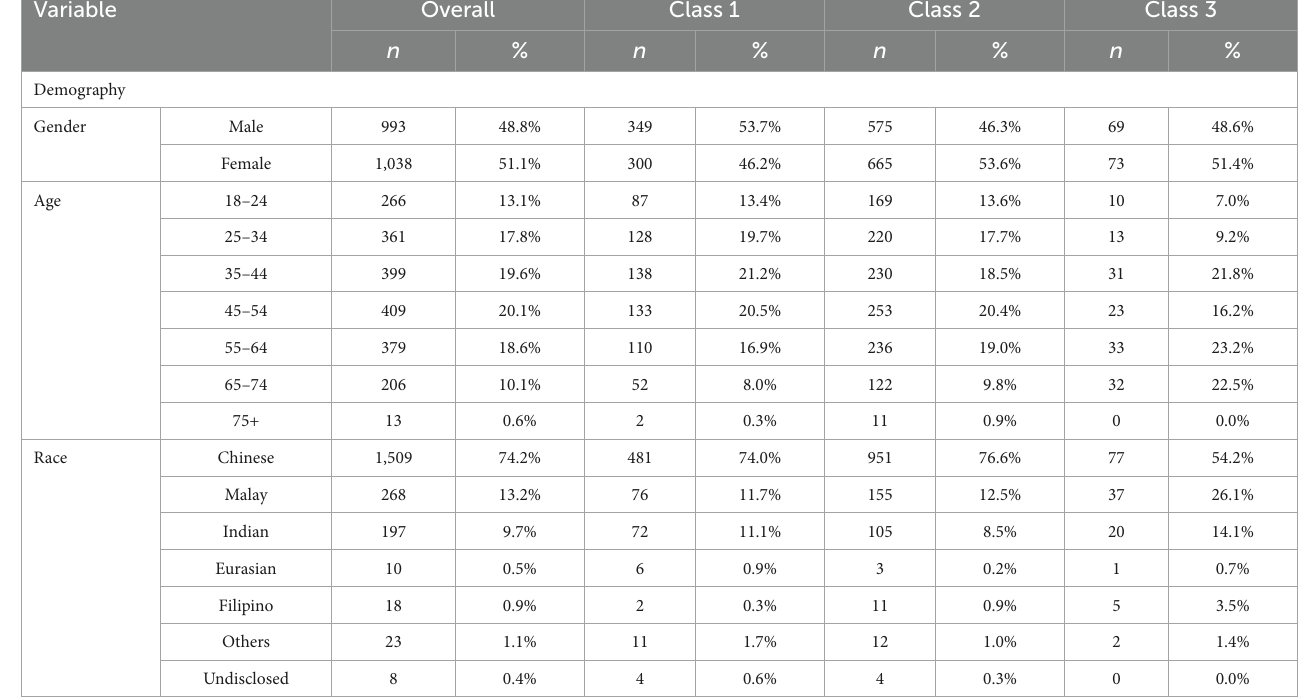
TABLE 2 Demographic differences between